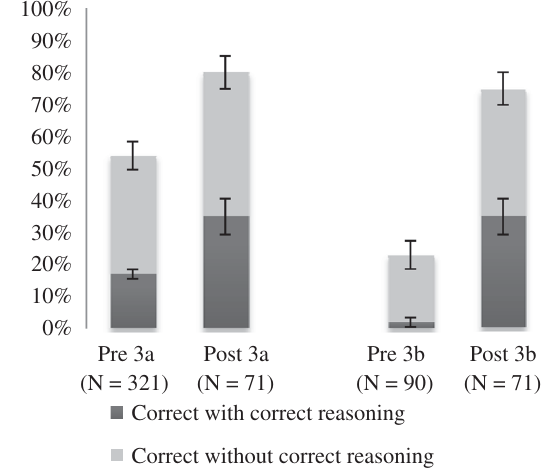
FIG. 7. Student performance on question 3, before and after completion of the tutorials. Error bars represent the standard